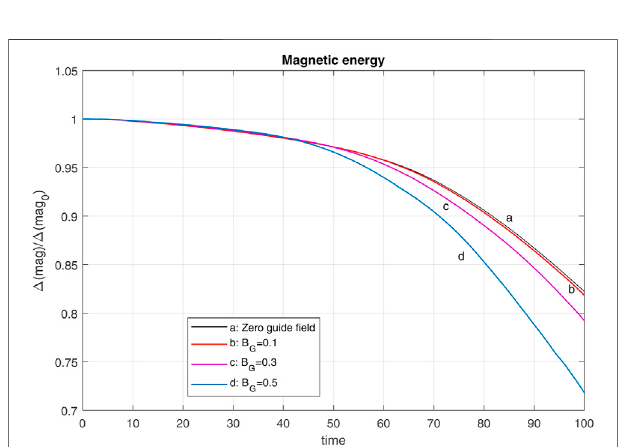
FIGURE 7 | Magnetic energy variation with uniform guide fi